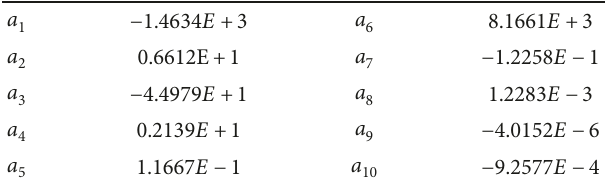
Table 5: a coe ffi cient